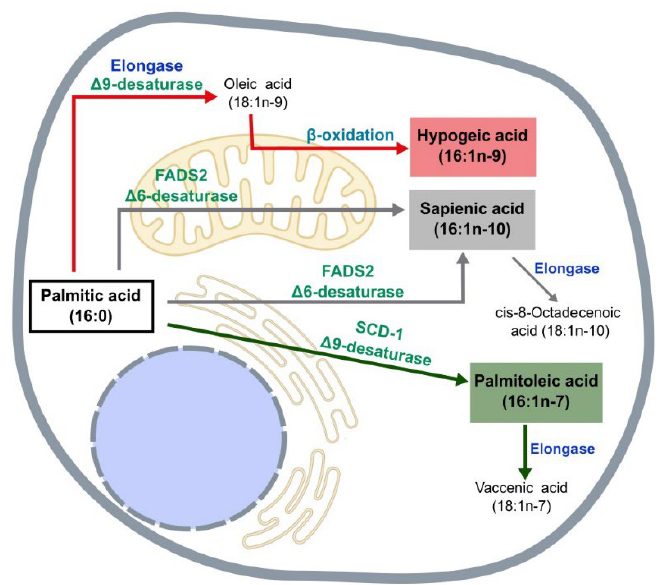
Figure 1. Pathways of biosynthesis of hexadecenoic fatty acids. Palmitoleic acid (16:1n-7) is synthesized in the endoplasmic reticulum via desaturation of palmitic acid (16:0) at C9 via SCD. Hypogeic acid (16:1n-9) is synthesized in the mitochondria via β -oxidation of oleic acid (18:1n-1). Sapienic acid (16:1n-10) is synthesized in the mitochondria and endoplasmic reticulum via desaturation of 16:0 at C6 via